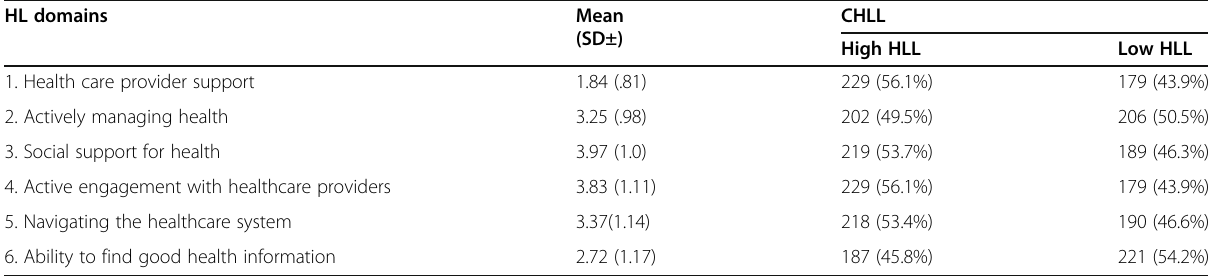
Table 2 Communicative health literacy level HL